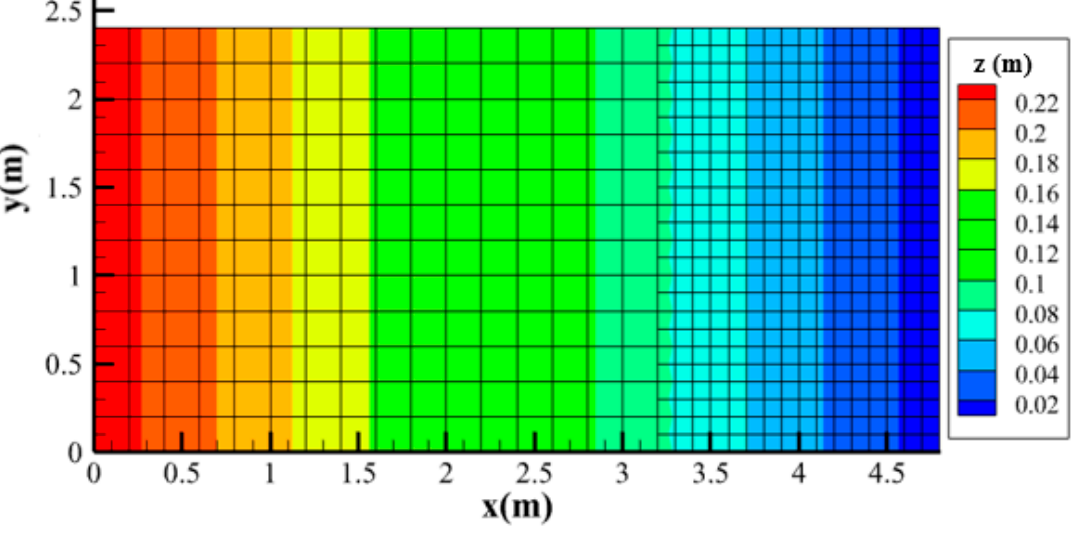
Figure 6. The grid partition of the case study.